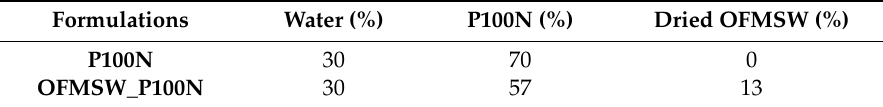
Table 1. Blends composition (dual step